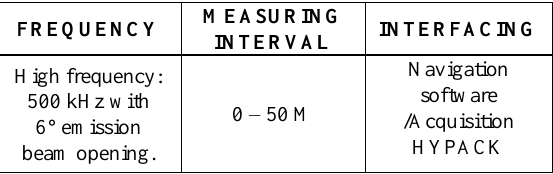
Table 1 . Characteristics of the sounder used